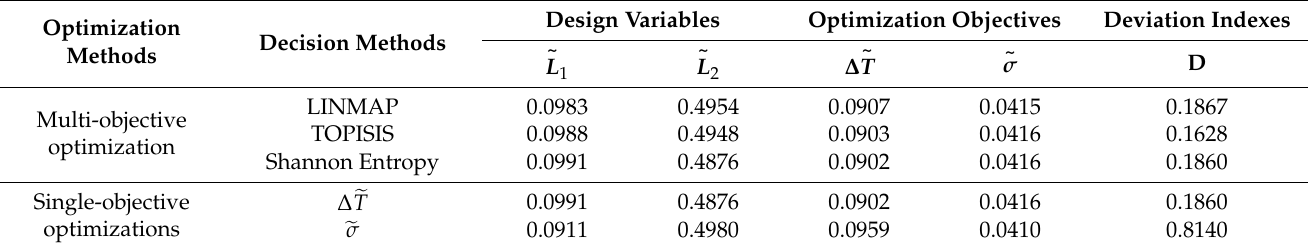
Table 2. Optimization results of the square HGB with different objectives under two-DOF